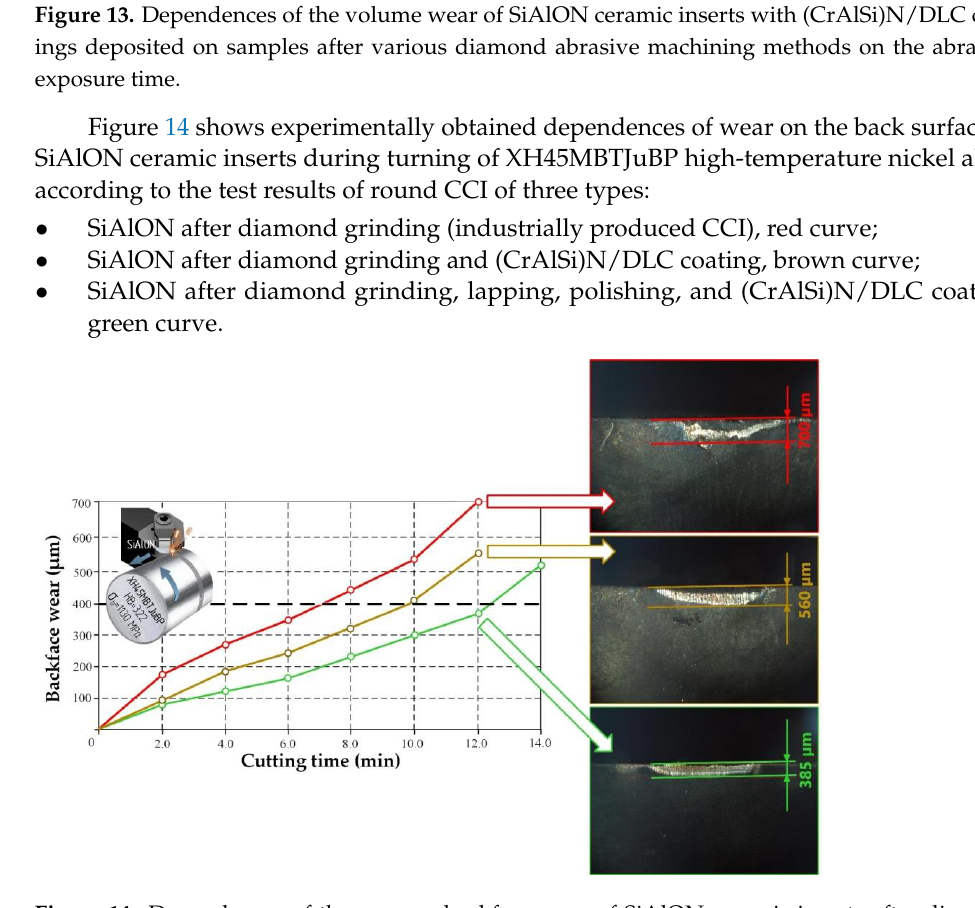
Figure 14. Dependences of the average backface wear of SiAlON ceramic inserts after diamond grinding (red curve), diamond grinding and (CrAlSi)N/DLC coating (brown curve), and diamond grinding, lapping, polishing, and (CrAlSi)N/DLC coating (green curve) on the cutting time when turning XH45MBTJuBP heat-resistant nickel alloy (V = 300 m/min, S = 0.2 mm/rpm, t = 0.8 mm).